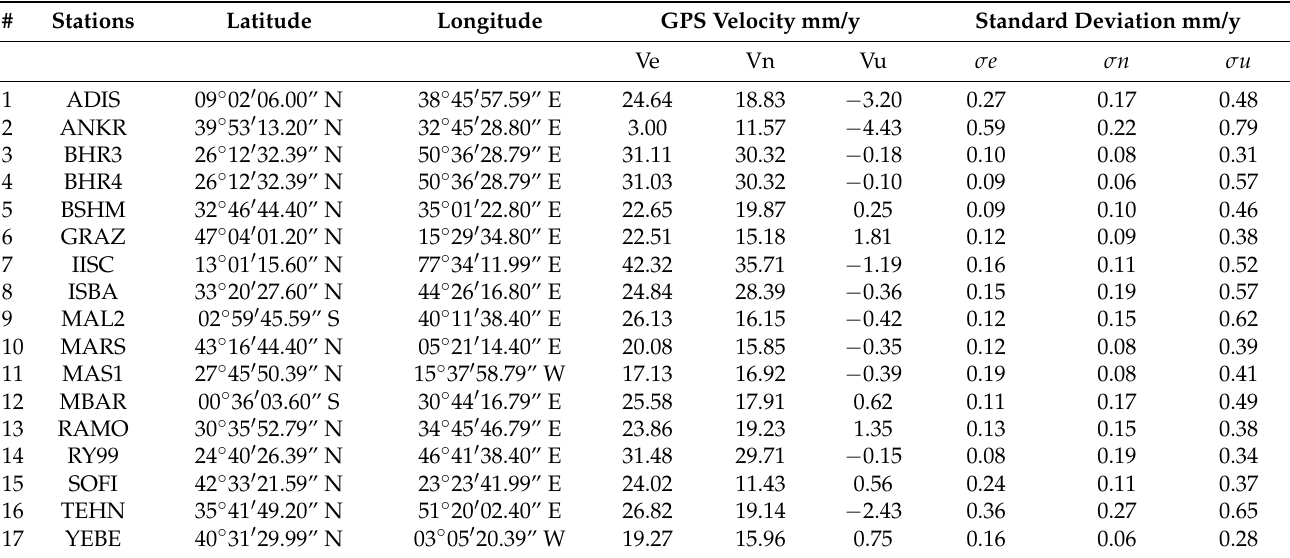
Table 3. GPS station position and velocities in east, north, and up components with uncertainties in mm/y relative to